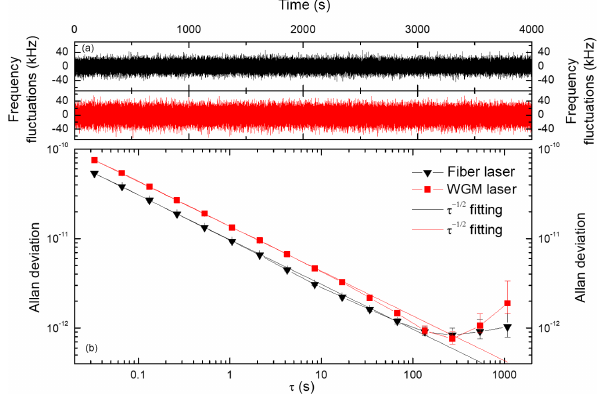
Figure 4. (a) The frequency deviation obtained from sD signals measured over 4000s for the EDFL (black curve) and the WGM laser (red curve); (b) the Allan deviation of the frequency deviation for the EDFL (black curve) and the WGM laser (red curve). The dotted lines correspond to the white noise